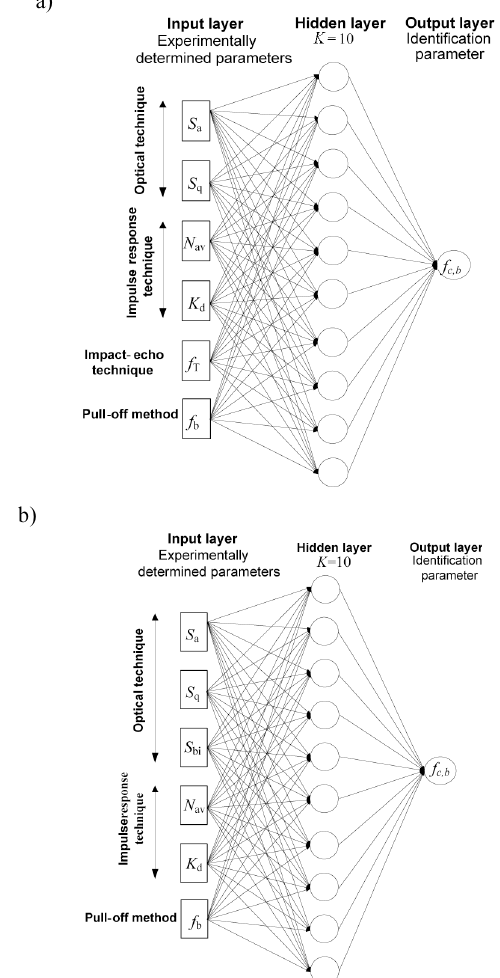
Fig. 9. Structure of ANN, adopted to be trained and tested from data acquired using respectively three nondestructive techniques (a) and two nondestructive techniques (b)